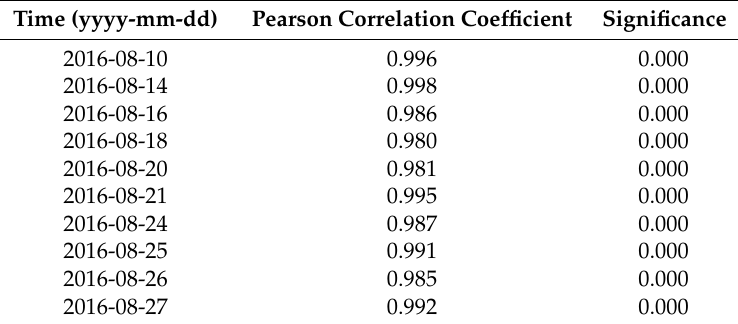
Table 1. Partial correlation analysis of SOCc and charging time.